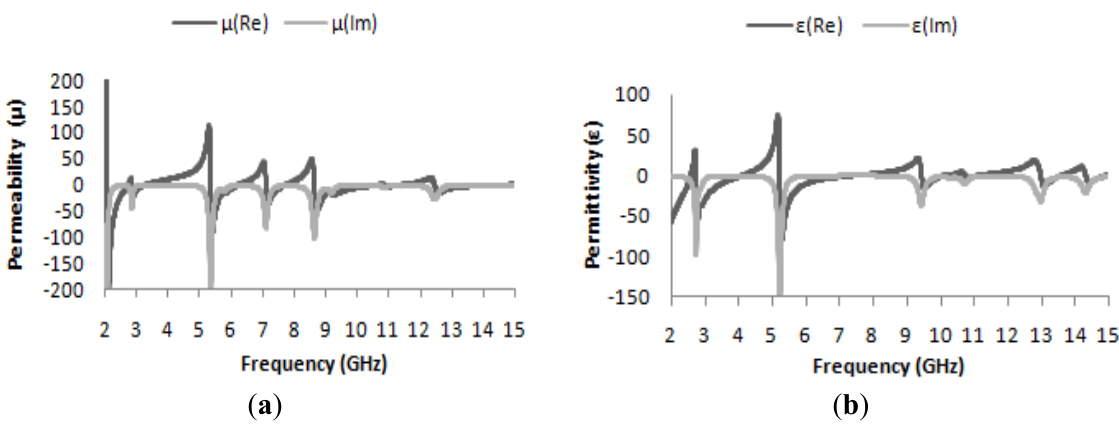
Figure 4. ( a ) Real and imaginary values of effective permeability (µ) vs. frequency; ( b ) real and imaginary values of effective permittivity (ε) vs. frequency.